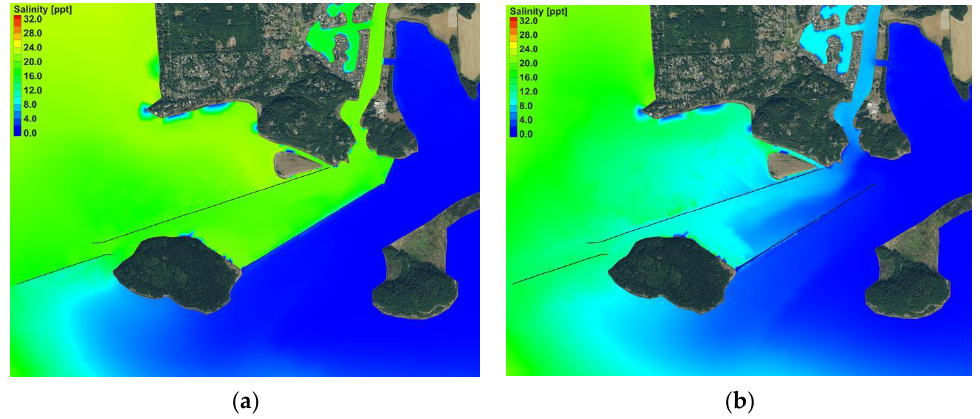
Figure 13. Time averaged salinity distribution (20 days) for ( a ) baseline conditions and ( b ) McGlinn Causeway restoration, SCN-2.